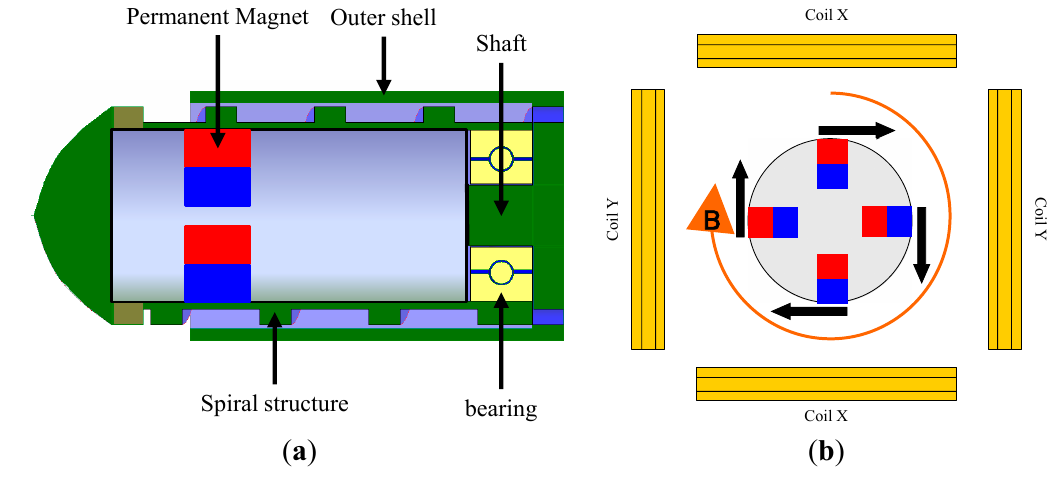
Figure 5. Permanent magnet actuated microrobot. ( a ) Structure of the microrobot; ( b ) Working principle.